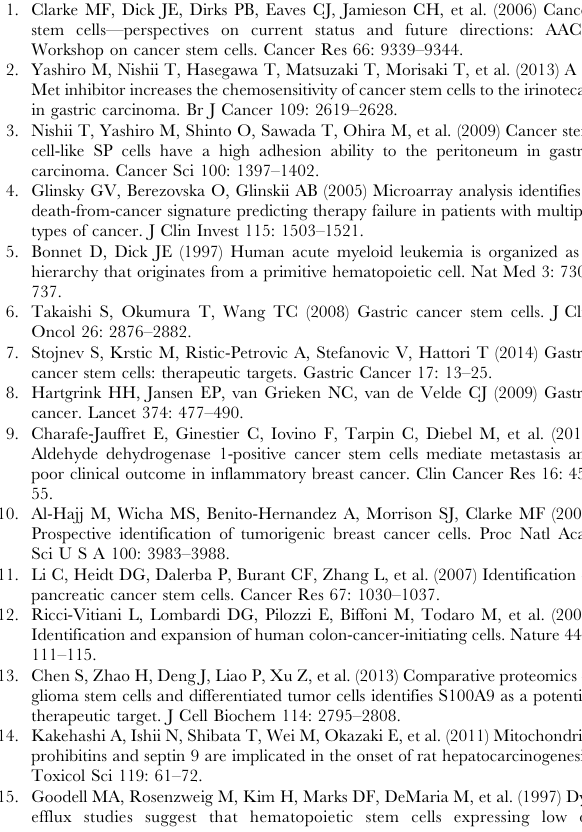
Figure S2 Stem cell markers expression. The expression level of CSC markers, CD44 , CD133 and NANOG was